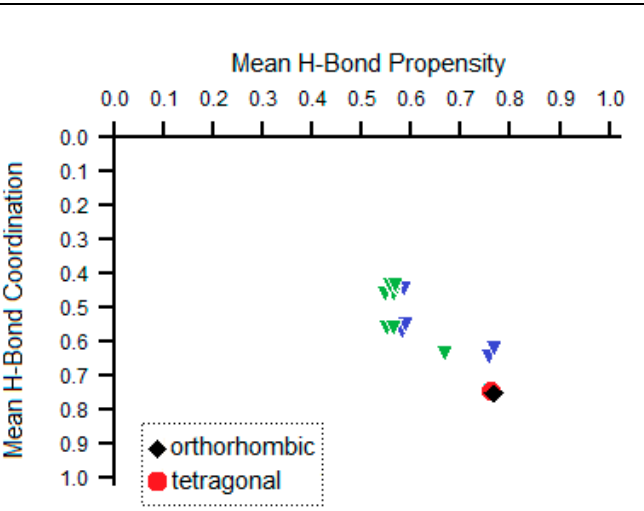
Figure 4. The putative structure landscape for favipiravir, expressed as mean H-bond coordination and propensity for different sets of H-bonds. Theoretically calculated sets of H-bonds are shown with triangles (blue and green correspond to 2 and 3 H-bond pairs for a molecule, respectively). The sets of H-bonds for actual orthorhombic (refcode {DOHVED} in the Cambridge Structural Database [30]) and tetragonal (optimized at VESTA) polymorphs are depicted in the black diamond and red circle, respectively.